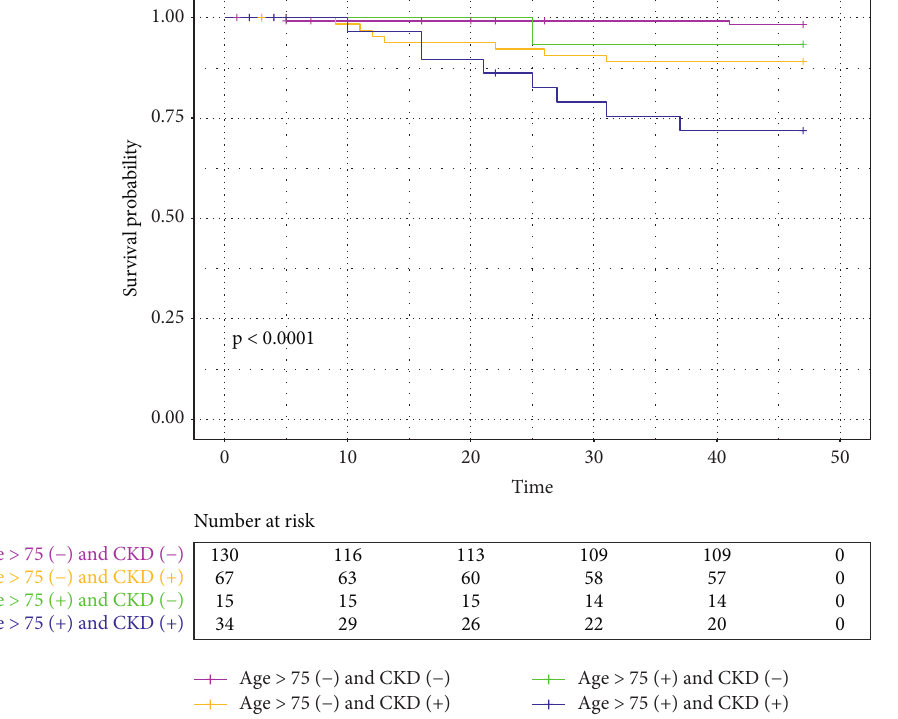
Figure 6: Kaplan–Meier for all-cause mortality in patients with and without CKD and age > 75 or < 75